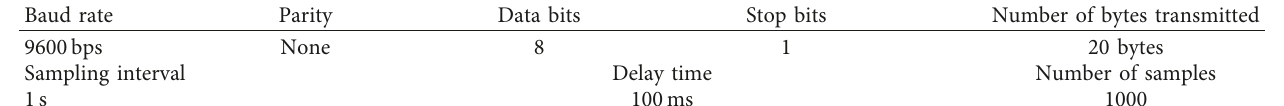
Table 2: The specifications of the data acquisition